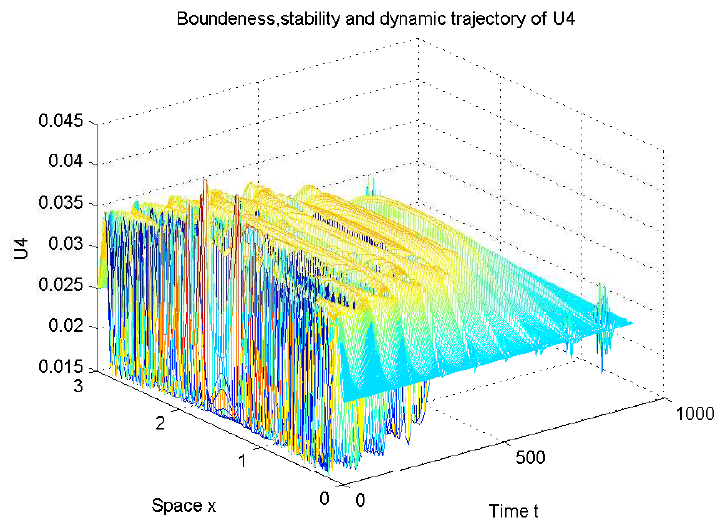
Figure 12. Computer simulation of dynamics of the price exponent U 3 .